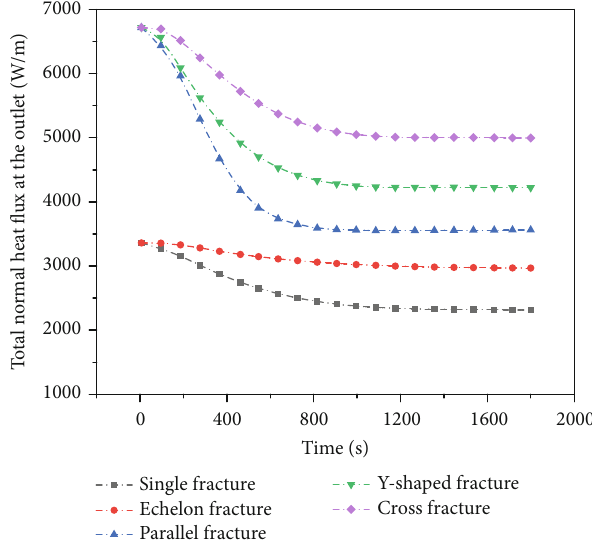
Figure 10: Variations of average outlet temperature at di ff erent fl uid injection